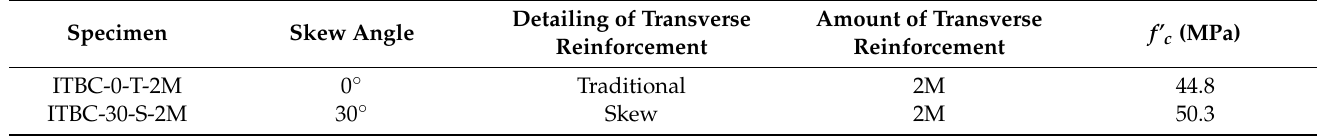
Table 1. Details of test